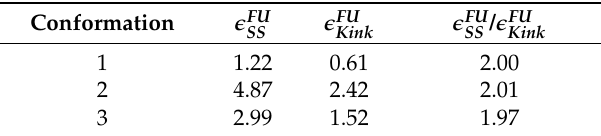
Table A3. Hencky strains at which the slip-spring and kink conformations of Figure A1 achieve a fully unraveled